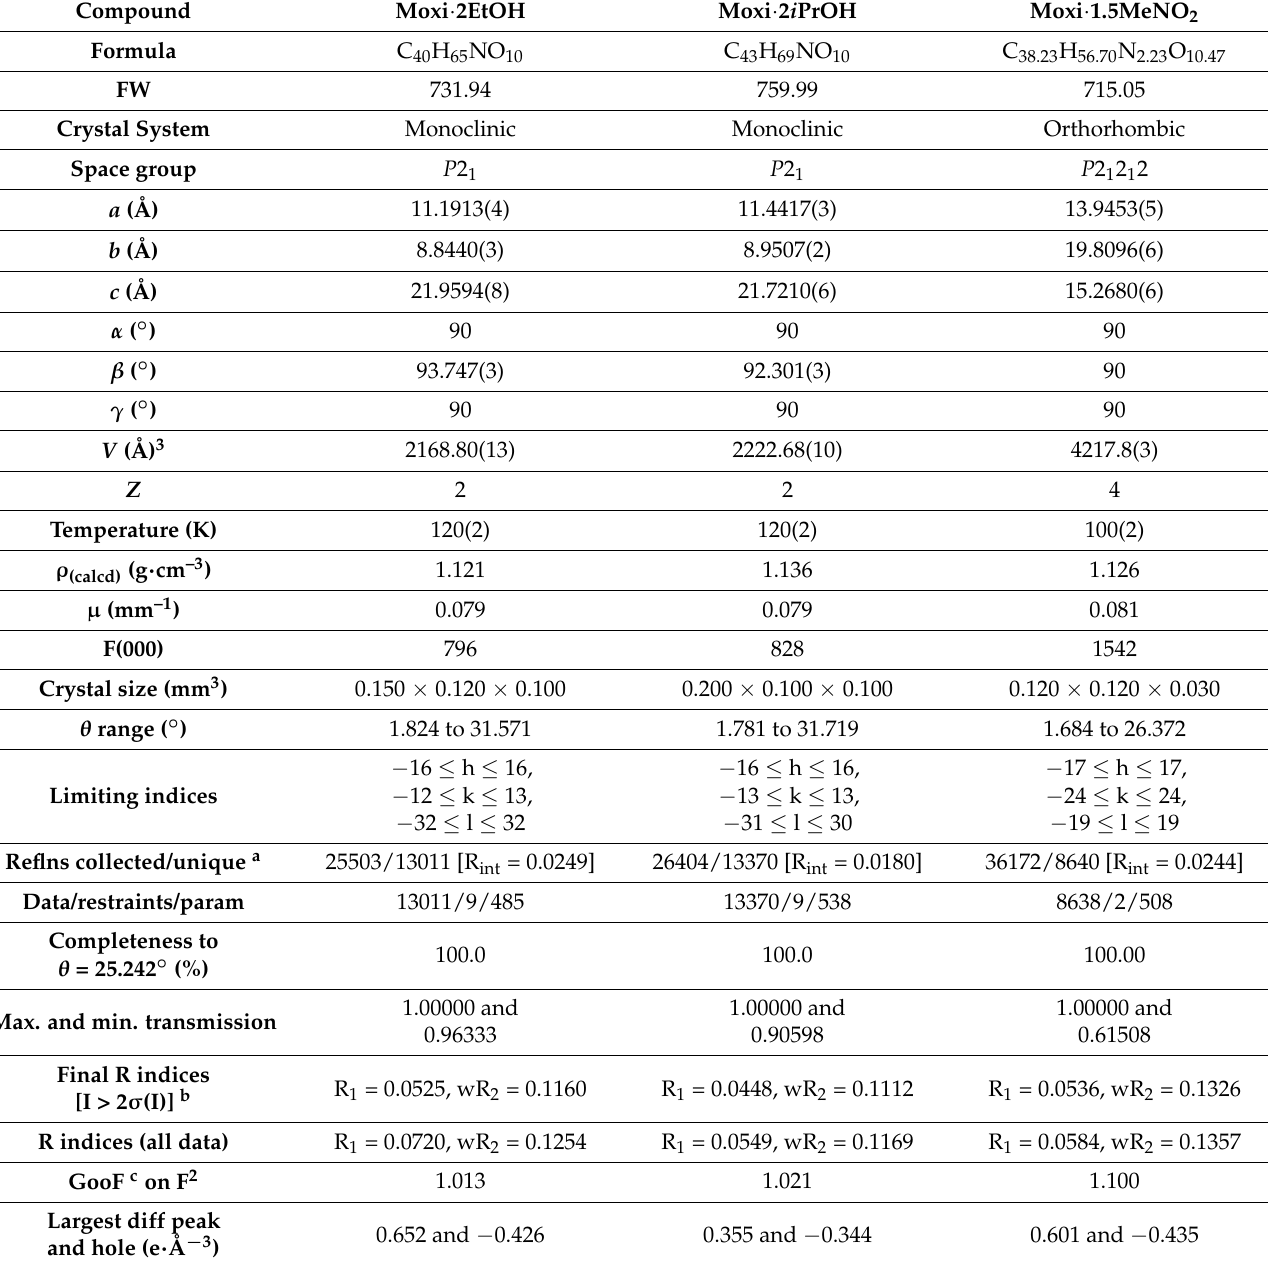
Table 2. Summary of crystallographic